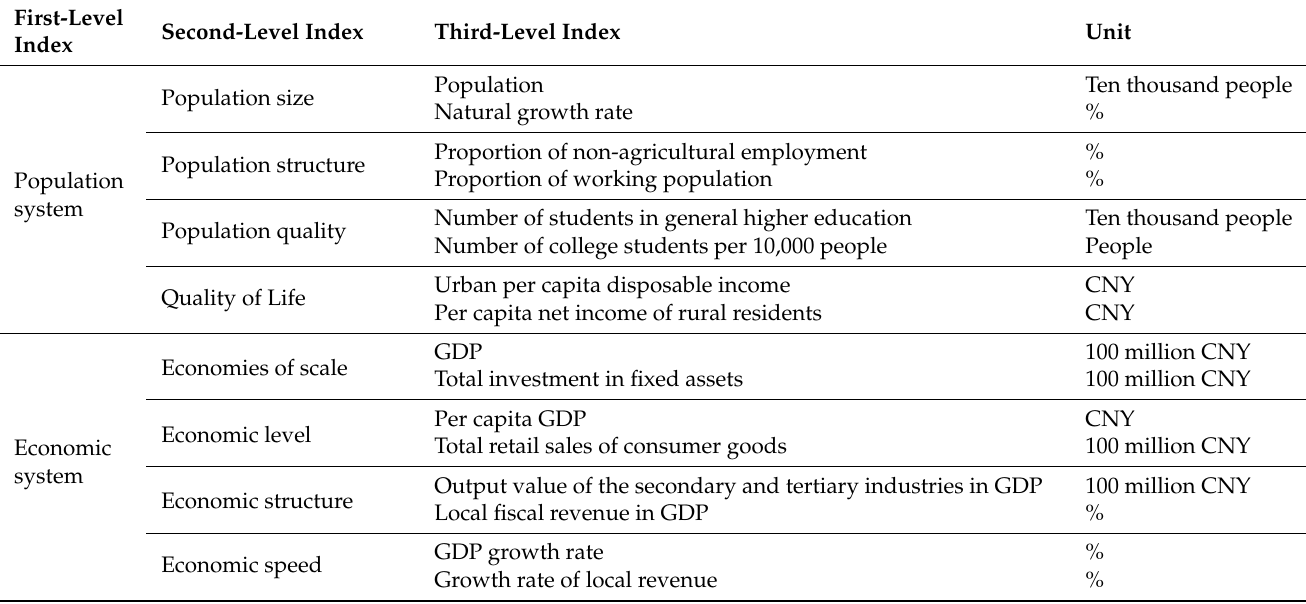
Table 1. Comprehensive evaluation index system for coupled and coordinative population–econ- omy development.